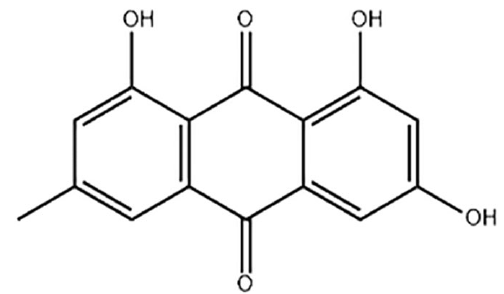
Figure 1. The structural formula of emodin.